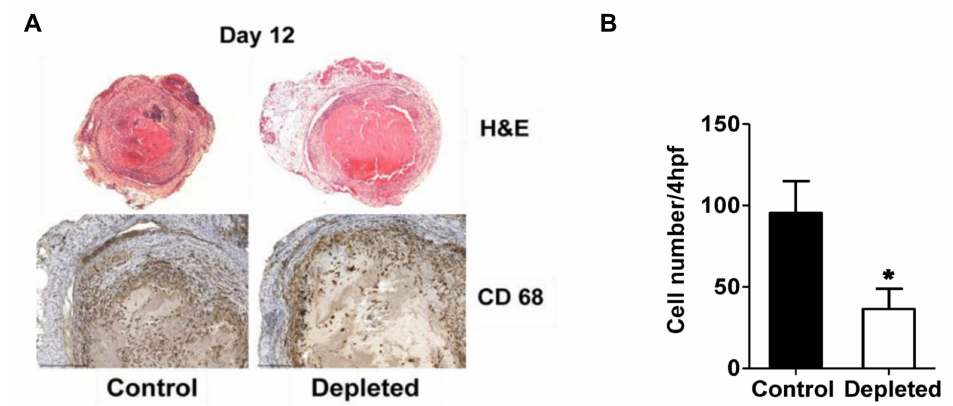
Figure 4. Depletion of T cells reduces intra-thrombotic macrophage numbers. ( A ) Histochemical analysisbyH&EstainingofvenousthrombisectionsfromcontrolandTcelldepletedmiceat12daysafter vena cava ligation (upper panel) and immunohistochemical analysis of intra-thrombotic macrophage accumulation using anti-CD68 antibodies in venous thrombi sections from control and T cell depleted mice at 12 days after vena cava ligation (lower panel). Original magnification, × 100 upper panel, × 200 lower panel. Representative results from 4–5 independent animals are shown. ( B ) Quantification of the numbers of CD68 positive cells (macrophages). All values represent the mean ± SEM ( n = 4–5). * p < 0.05, control versus T-cell